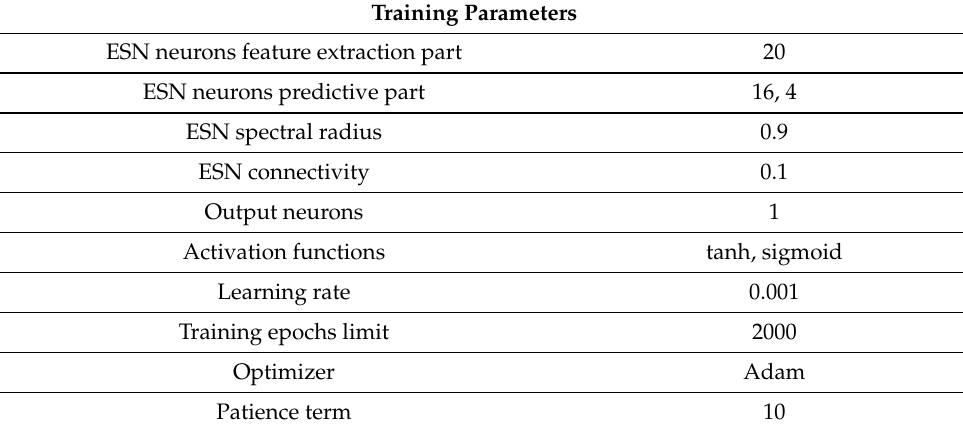
Table 1. Proposed model